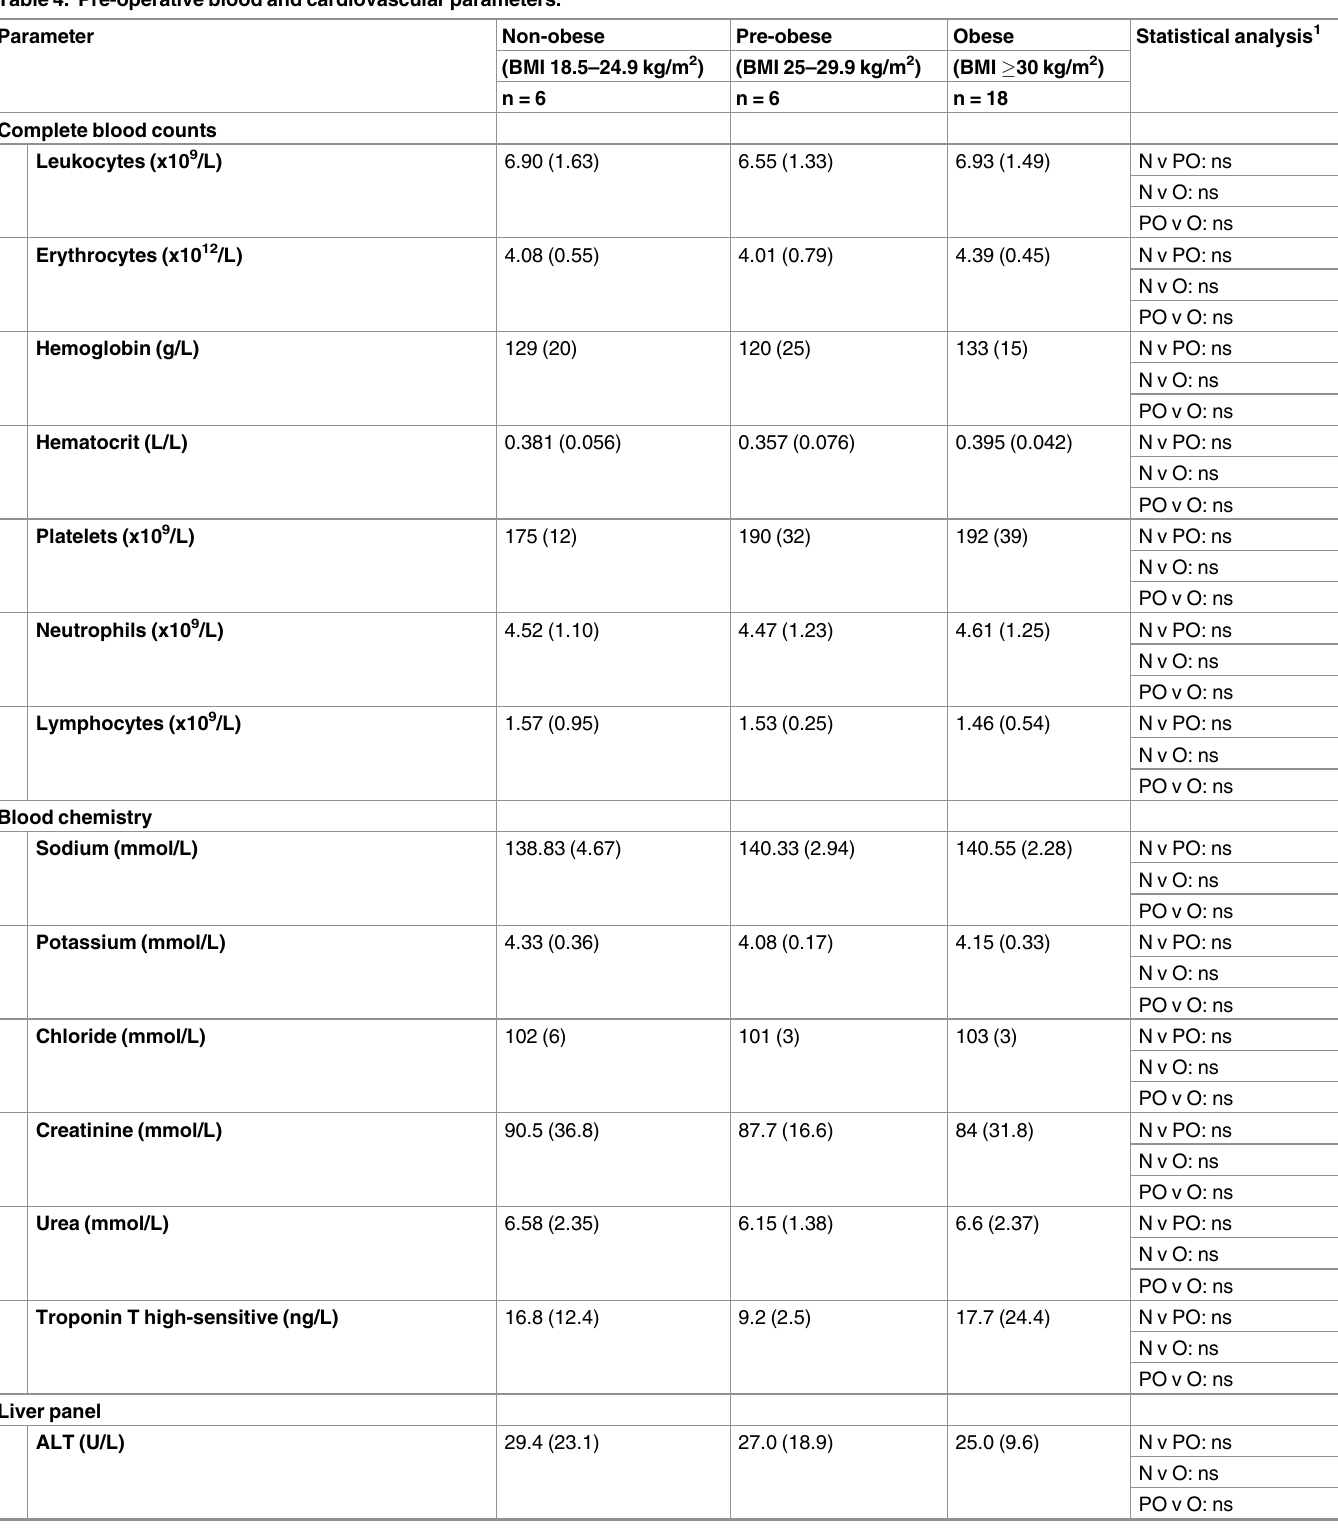
Table 4. Pre-operative blood and cardiovascular